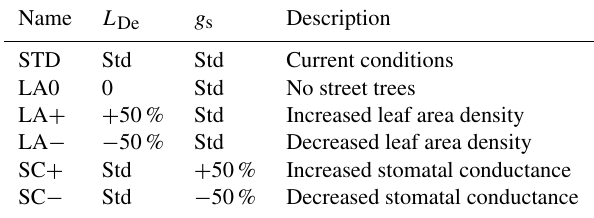
Table 1. Summary of numerical experiments and changes in the parameters used for the sensitivity study. Std indicates the standard value(s) as provided in Sect. 3.2. The other parameters are kept con- stant with the values provided in Sect.